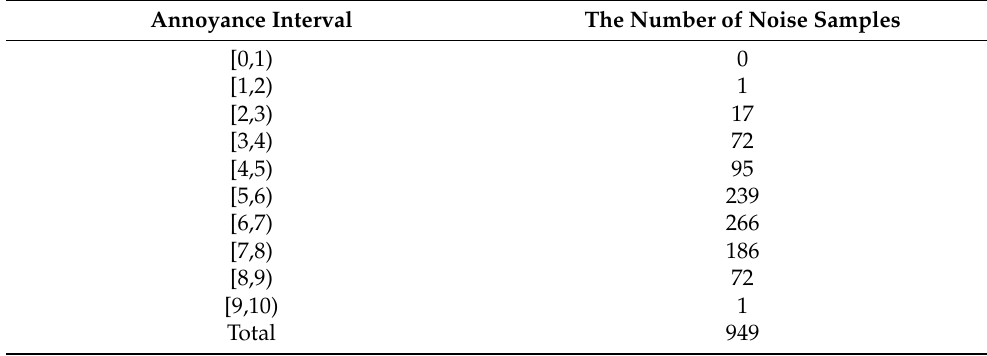
Table 1. Results after post-processing and annoyance distribution of listening experiment. Adopting the 11-level assessment scale [27], in this paper, the range of annoyance is (0,10).